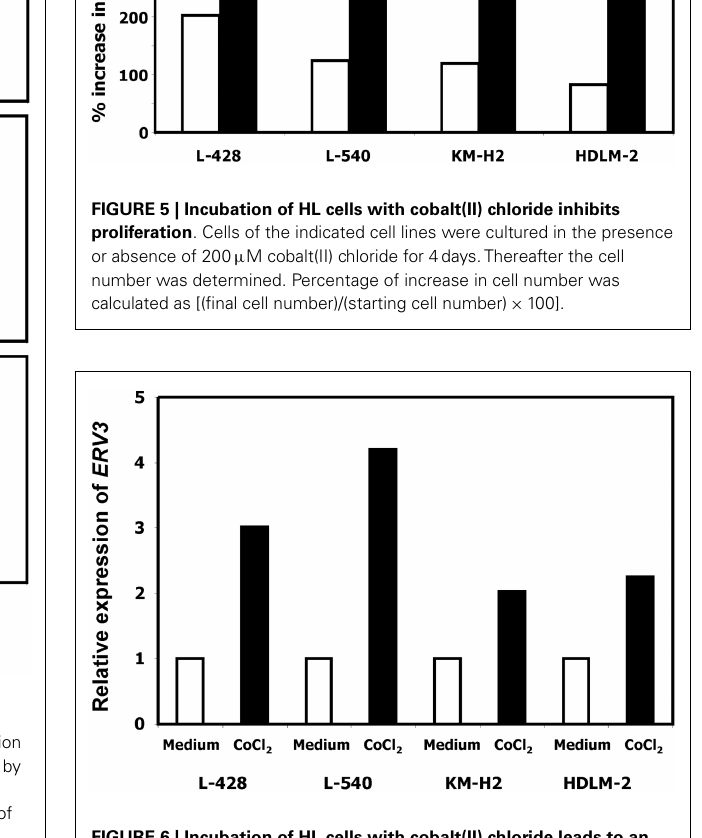
FIGURE 6 | Incubation of HL cells with cobalt(II) chloride leads to an increased expression of ERV3 . Expression of ERV3 was analyzed in HL cell lines L-428, L-540, KM-H2, and HDLM-2 after treatment with 200 µ M cobalt(II) chloride or without cobalt(II) chloride by quantitative RT-PCR. Beta actin was used as housekeeping control and the mean of HL cells without cobalt(II) chloride was set as